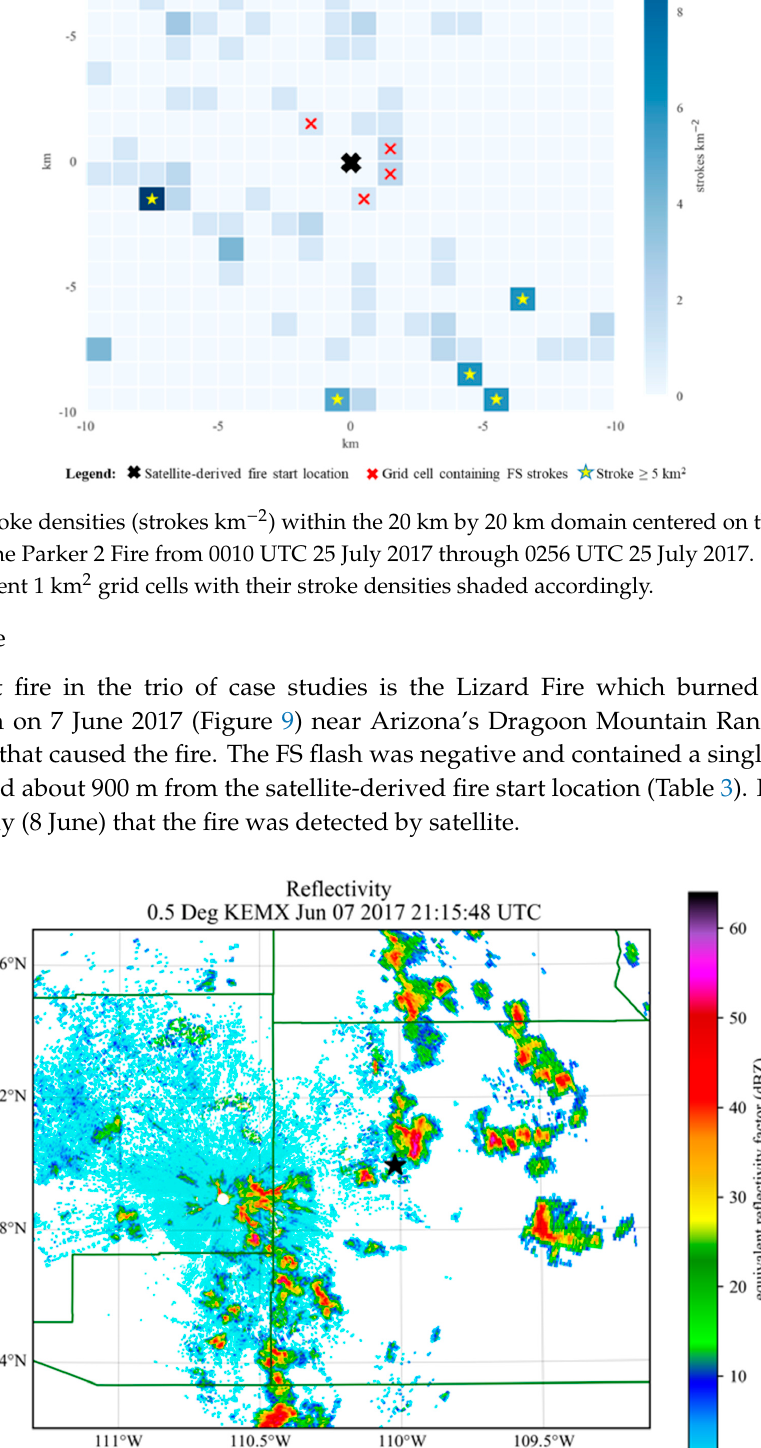
Figure 7. Base reflectivity (dBZ) from the WSR-88D radar in Medford, OR showing FS stroke locations (circles) near the times of their discharge at a ) 0110 UTC b ) 0117 UTC and c ) 0156 UTC 25 July 2017 [45].